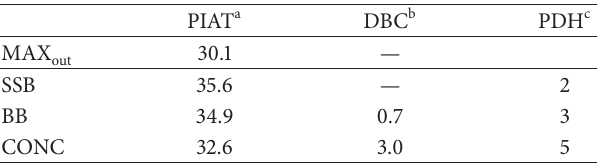
Table 3: Outdoor and indoor air temperatures of model 9 and the control model. PIAT